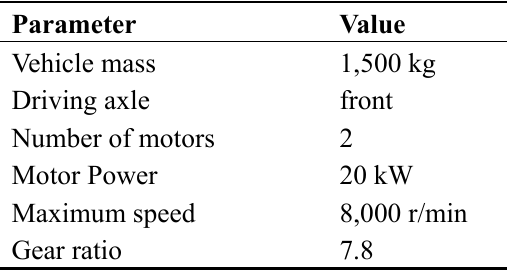
Figure 1. Chassis layout of vehicle model. Table 1. Main parameters of vehicle.